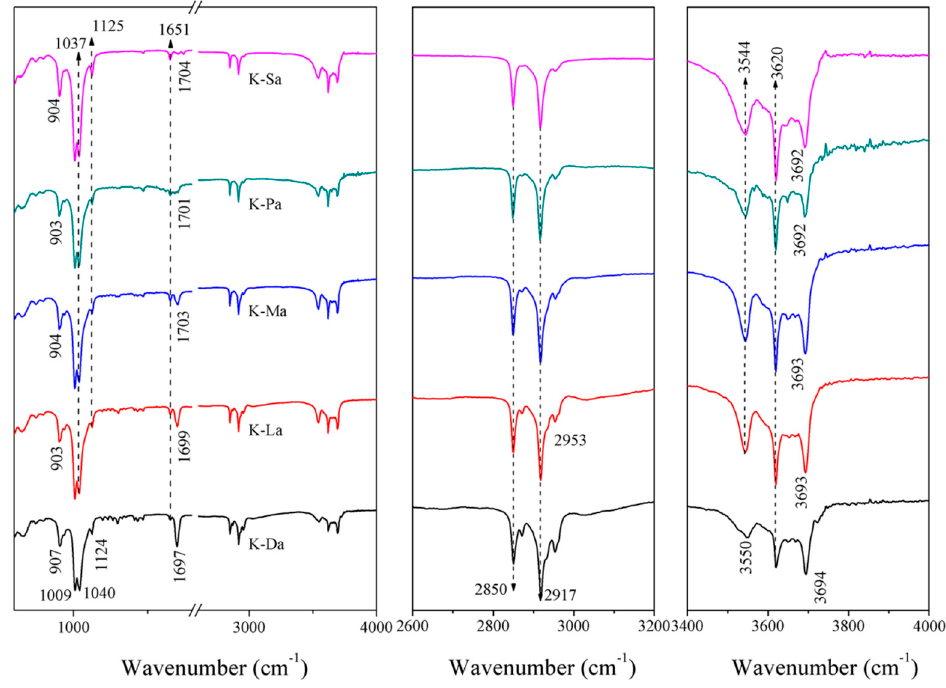
Figure 6. FTIR vibration spectra of kaolinite/fatty acid intercalation compounds (K-Fas).